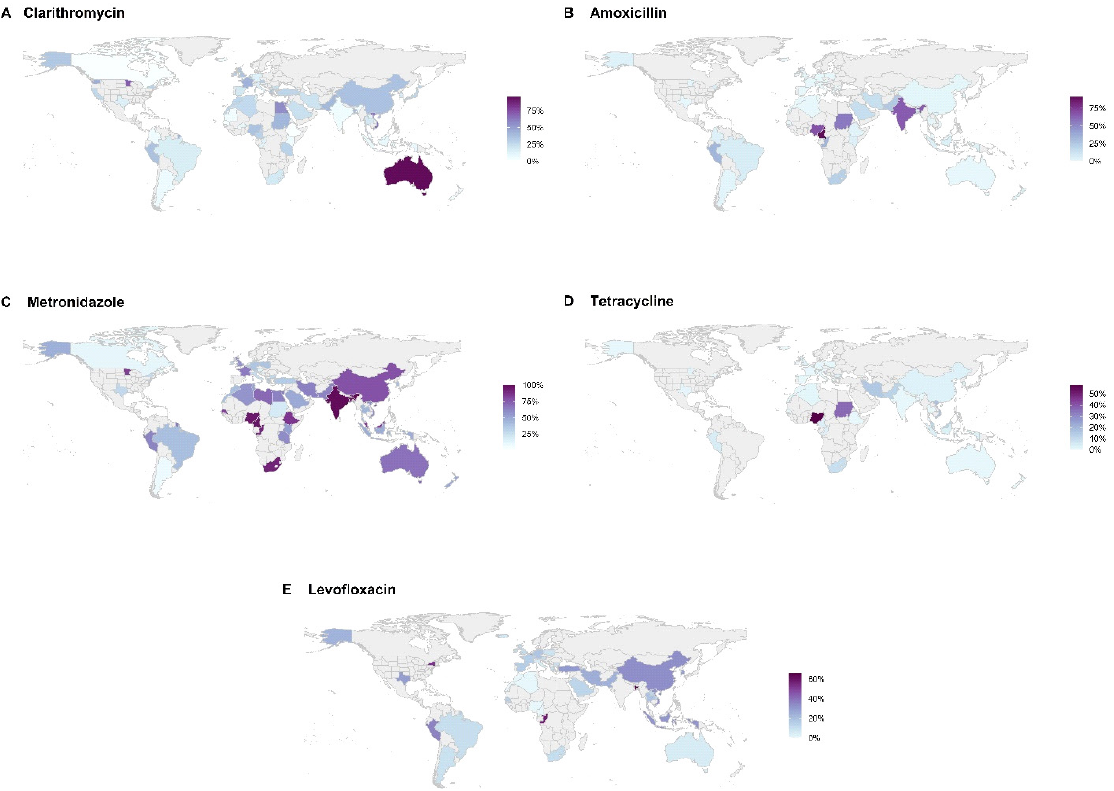
Figure 1. Regional rates of resistance are separated by clarithromycin ( A ), amoxicillin ( B ), metroni- dazole ( C ), tetracycline ( D ), and levofloxacin ( E ). However, there were insufficient data to ade- quately illustrate rifabutin resistance. Areas in gray indicate no data available from the references that were used [3–5].